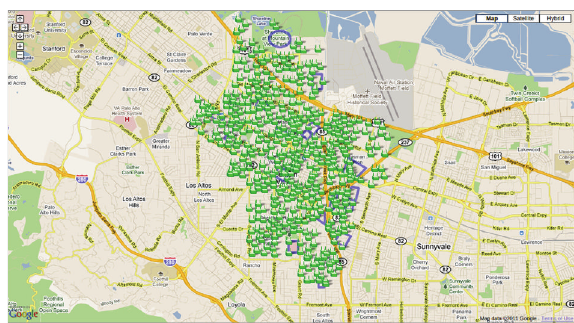
Figure 4: Google WiFi Network in Mountain View, CA.